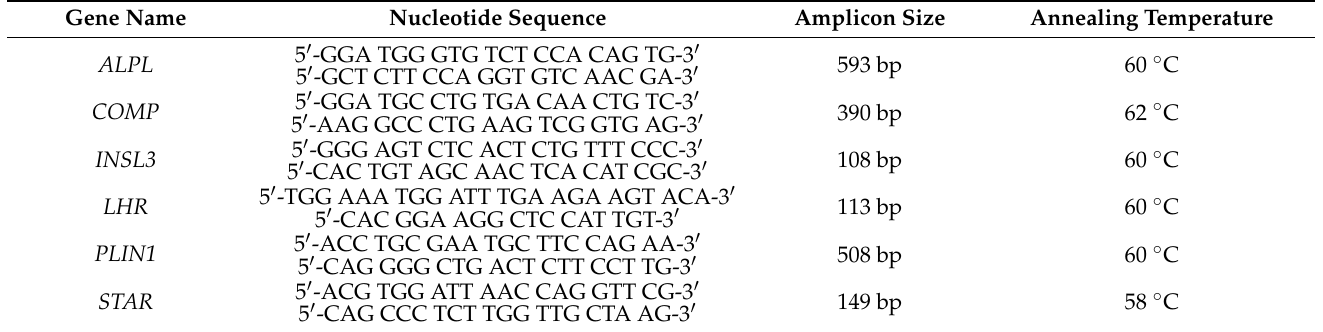
Table A2. List of oligonucleotide primer pairs used for qPCR amplification.